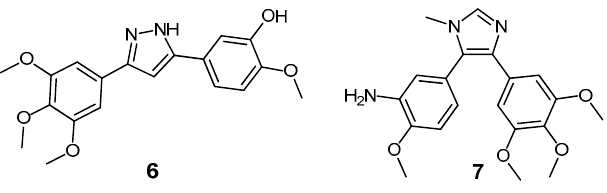
Figure 3. Structures combretastatin derivatives 6 and 7 .